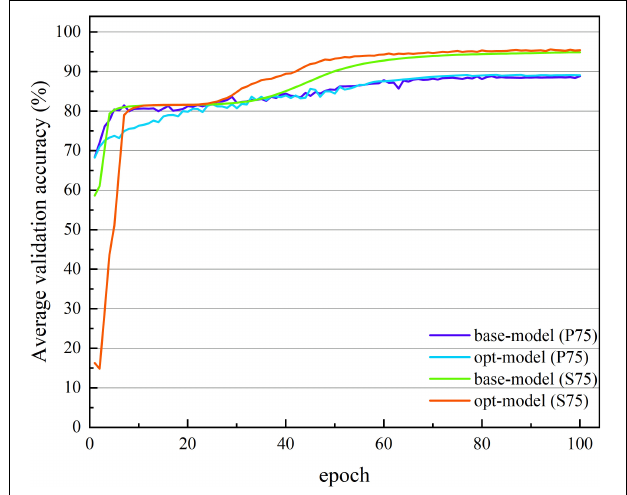
FIGURE 7 | The average verification accuracy curve of two network structures. The abscissa is the number of iterations, whose range of values is from 1 to 100; and the ordinate is the average verification accuracy rate, whose range of values is from 14.789 to